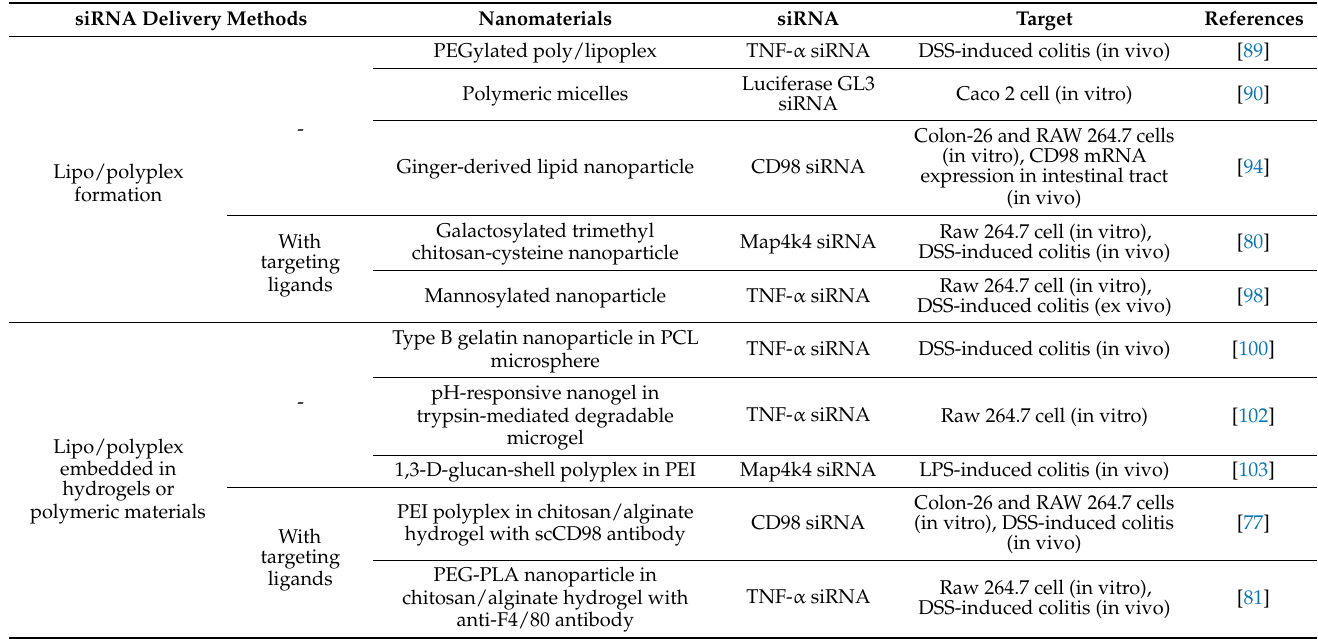
Table 2. Oral siRNA nano-delivery systems for IBD